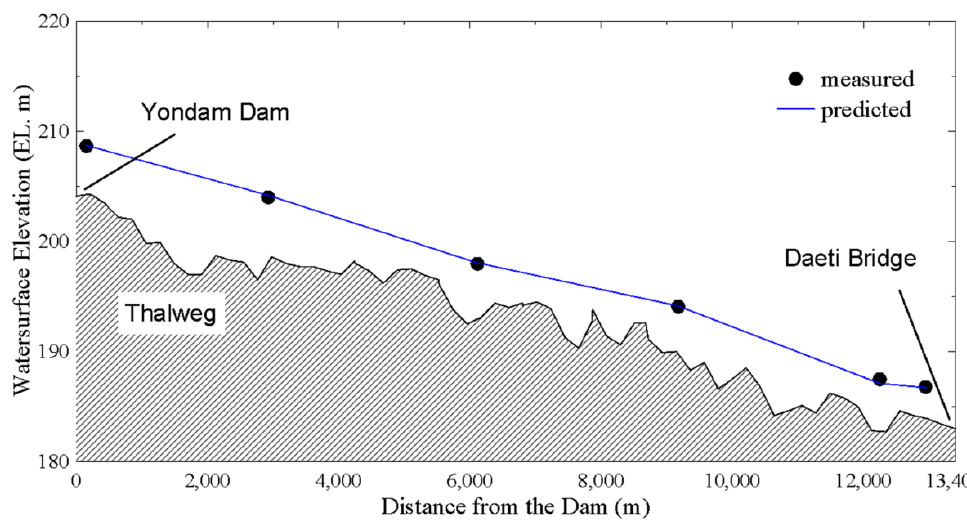
Figure 3. The validation of the flow modelling.